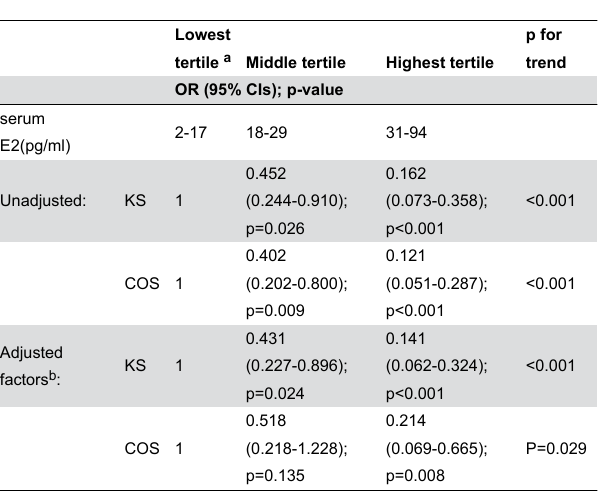
Table 5. Odds ratios (OR) and 95% confidence intervals (CIs) for kidney stones (KS) and calcium oxalate stones (COS) according to tertiles of E2